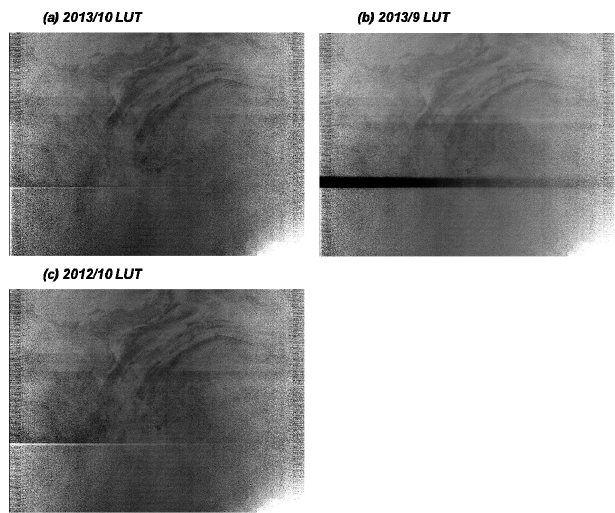
Figure 13. Stray light corrected images for October 5, 2013, 1:41 GMT, using LUTs derived from ( a ) 2013 October, ( b ) 2013 September, and ( c ) 2012 October data.